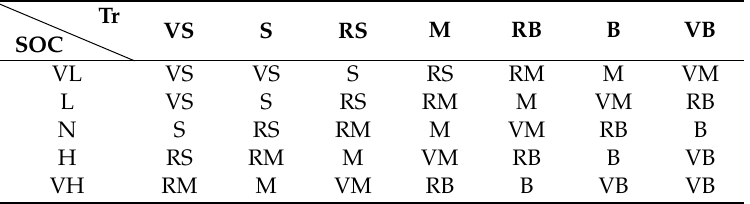
Table 1. Control rules set by the fuzzy